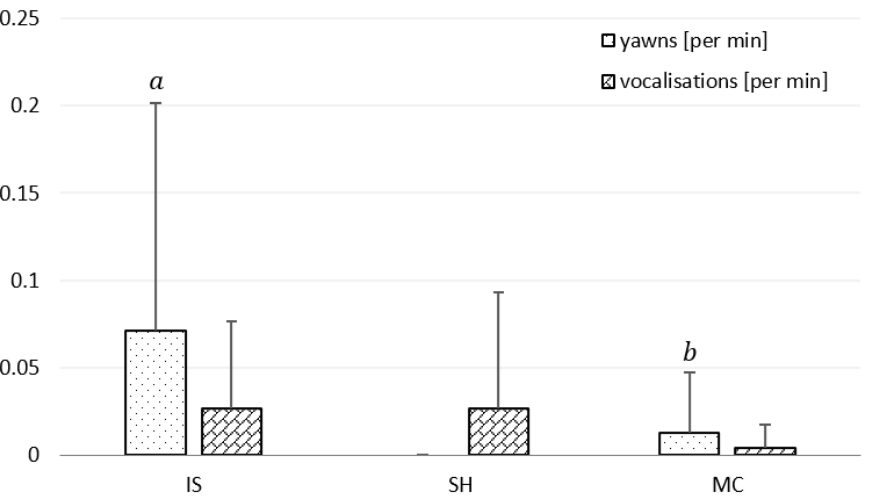
Figure 3. Mean rate of yawns and vocalisations per min with regard to the paddock conditions: IS—insolated, SH—shaded, MC—under mist curtain. Vertical lines show the standard deviation. Means marked with different letters within yawns significantly differ at p < 0.05; no letters indicate that significant differences do not appear.